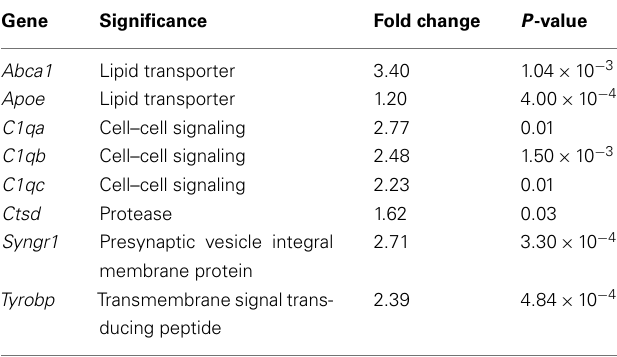
Table 2 | Genes differentially expressed in regions of induced young adult neurogenesis known to be involved in synaptic development, function, and plasticity.